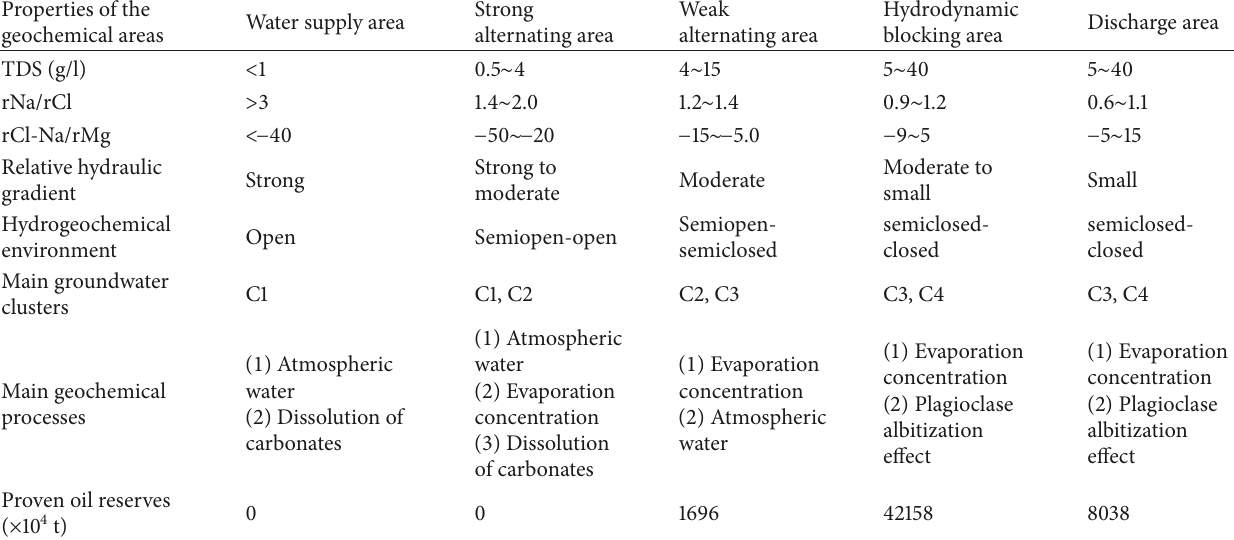
Table 3: Main geochemical areas and geological and hydrogeological contexts related to groundwater